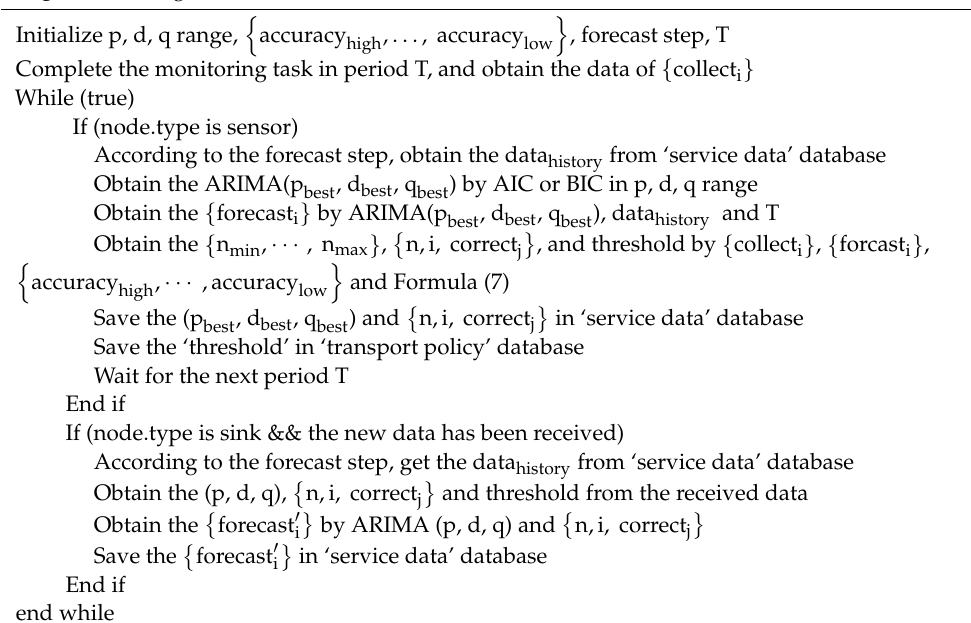
Algorithm 1 Edge Prediction Based on ARMA